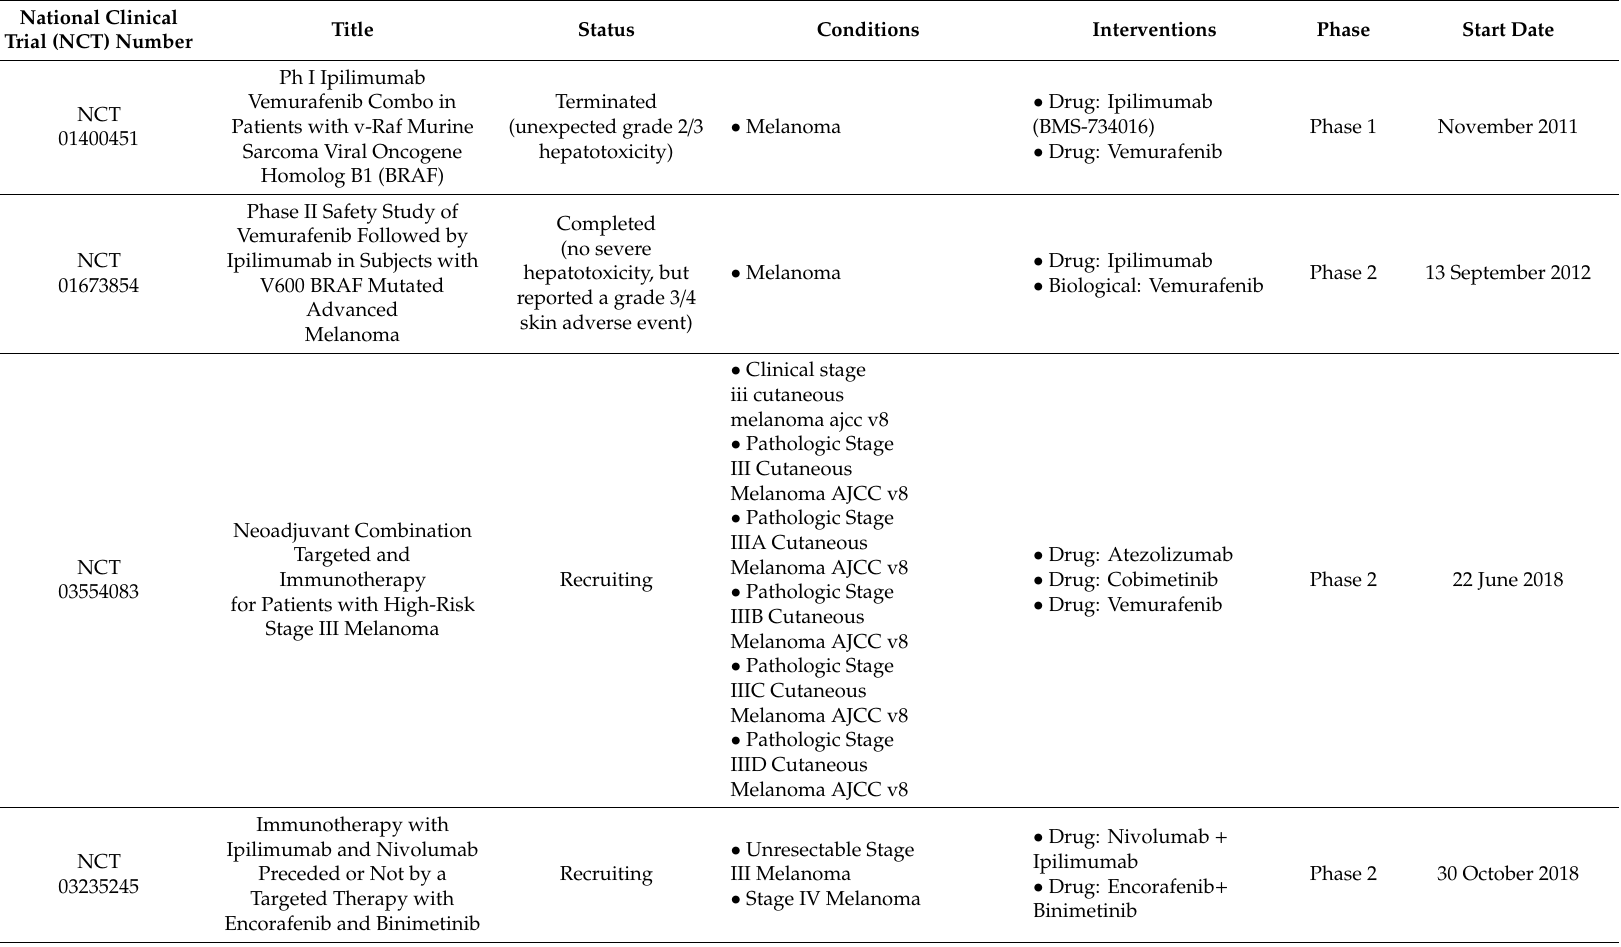
Table 5. Clinical trials of therapies targeting the MAPK pathway and immunotherapy in patients with